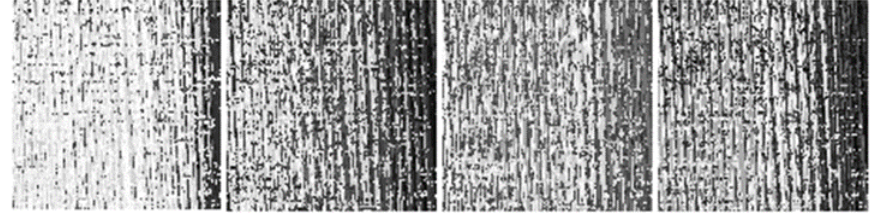
Figure 9. Samples of ORL’s subjects encrypted face images .